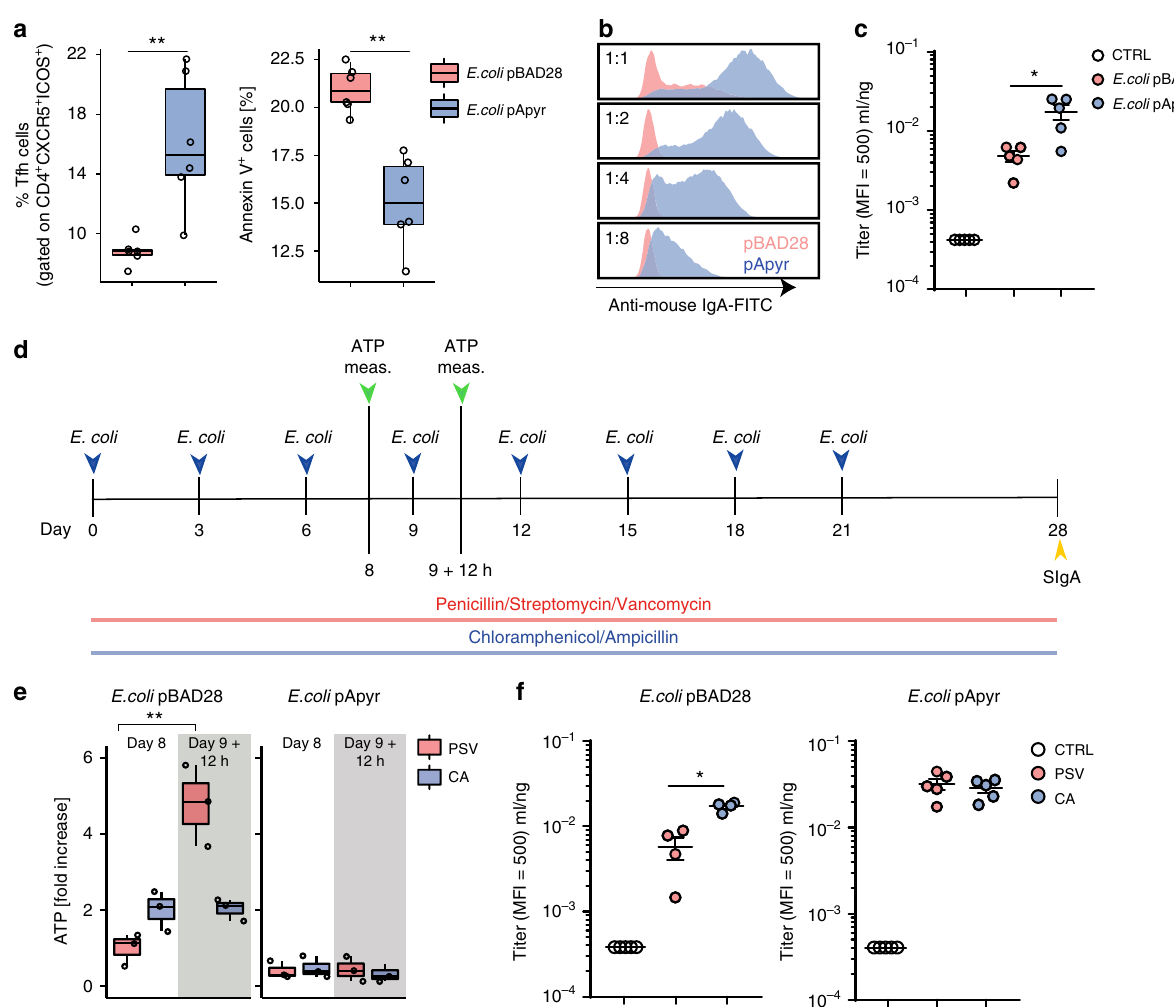
Fig. 3 Induction of anti- E. coli SIgA by expression of apyrase. a Statistical analysis by fl ow cytometry of Tfh cells and Annexin V + cells within Tfh cells from PPs of mice immunized with E.coli pBAD28 or E.coli pApyr at day 22. b Flow cytometry for anti- E. coli IgA in intestinal wash from mice immunized with E. coli pBAD28 or E. coli pApyr . c Intestinal anti- E.coli IgA titer in non-immunized mice (CTRL) and mice immunized with E. coli pBAD28 or E. coli pApyr . d Diagram showing the immunization protocol with E.coli pBAD28 and E.coli pApyr in mice maintained with Chloramphenicol and Ampicillin (CA) (a bactericidal mix active on endogenous fl ora but not on CA-resistant E. coli pBAD28 and E. coli pApyr ) or Penicillin/Streptomycin/Vancomycin (PSV) (bactericidal on both endogenous fl ora as well as E. coli transformants) in drinking water. e Fold increase of ileal ATP in mice maintained in PSV or CA before (day 8) and 12 h after (day 9 + 12 h) orogastric gavage with the indicated transformants. f Intestinal anti- E.coli IgA titer in untreated mice (CTRL) or in response to E. coli pBAD28 (left panel) or E. coli pApyr (right panel) gavaging in mice maintained in PSV or CA. The boxplots in a and e show median and upper and lower quartiles. The extreme lines show the highest and lowest value . The boxplot is overlaid with the visualization of single observations. Two-tailed Mann – Whitney U -tests. ** p < 0.01 a and Kruskal – Wallis with Dunn ’ s post-test. * p < 0.05, ** p < 0.01 c , e , f . One representative experiment out of at